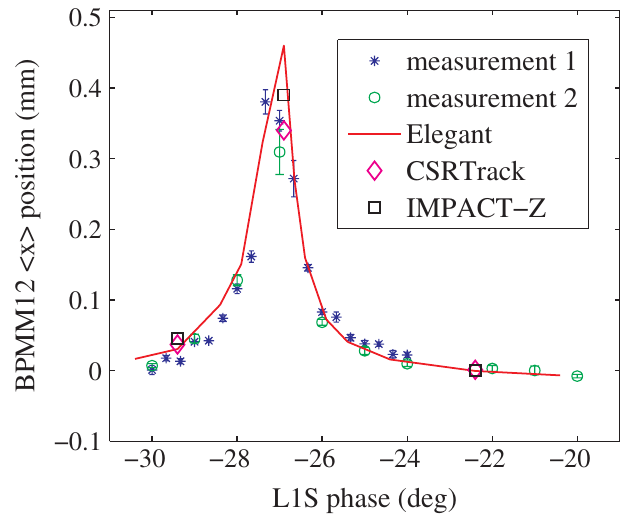
FIG. 4. (Color) Post-BC1 BPMM12 x position vs L1S phase to monitor CSR energy loss.